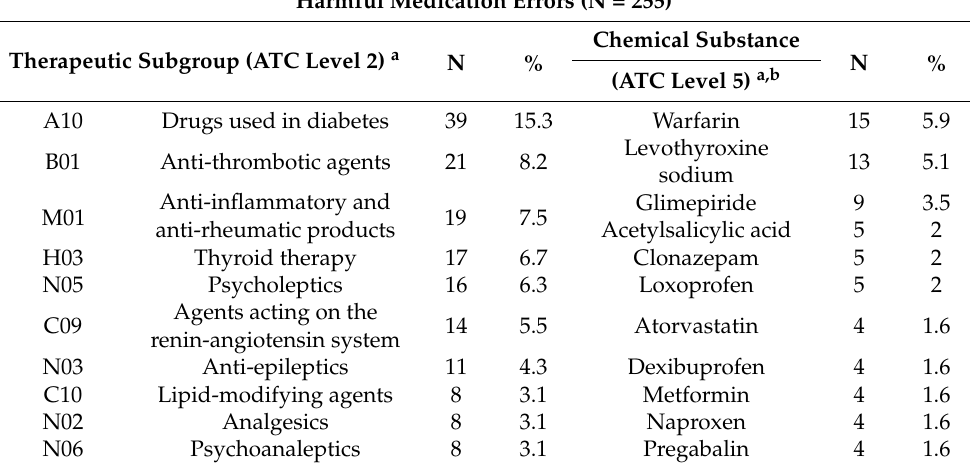
Table 3. Frequently reported therapeutic classes and chemical substances associated with harmful medication